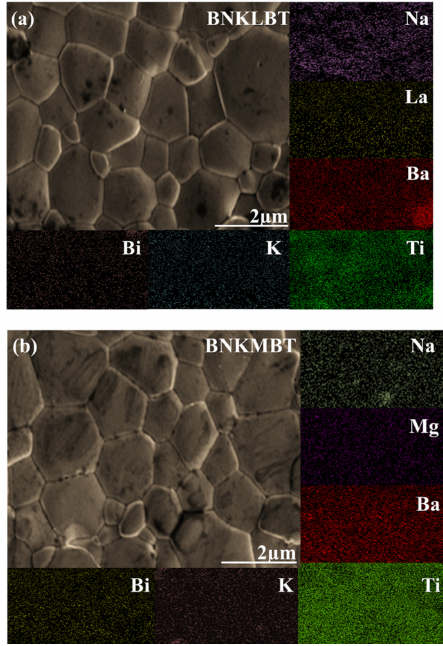
Figure 3. ( a ) Morphological and colored elemental mapping of elements in the BNKLBT ceramic. ( b ) Morphological and colored elemental mapping of elements in the BNKMBT